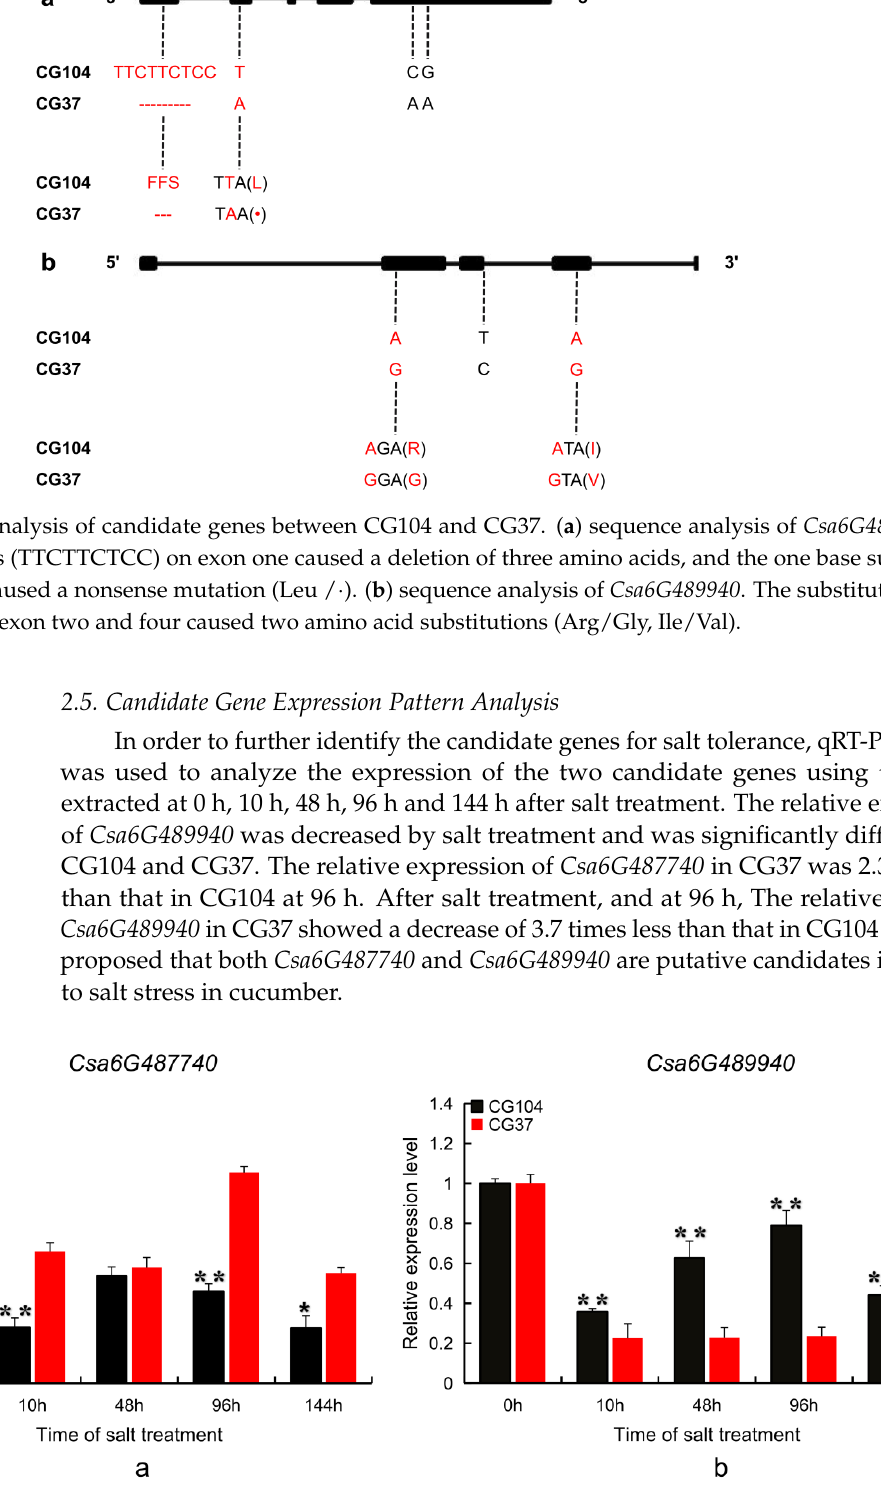
Figure 6. Relative quantitative expression analysis of Csa6G487740 and Csa6G489940 in CG104 and CG37. ( a ) Relative quantitative expression analysis of Csa6G487740 ; ( b ) Relative quantitative expression analysis of Csa6G489940 . Black squares indicate the relative expression levels of the candidate genes at different treatment times (0 h, 10 h, 48 h, 96 h, and 144 h) after salt treatment in CG104; red squares indicate the relative expression levels of candidate genes in CG37; the error bars represent the standard error of three biological replicates; * Significant difference ( p < 0.05); ** Significant difference ( p < 0.01).